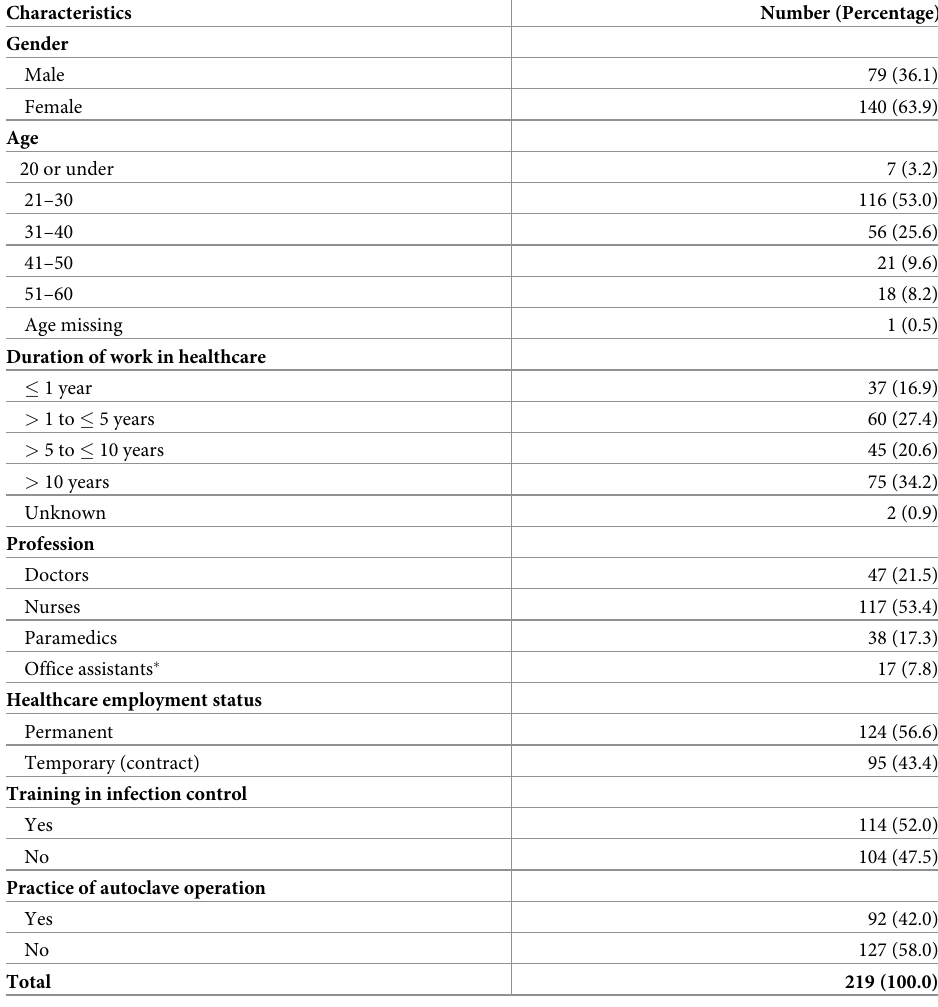
Table 1. Characteristics of healthcare workers participating in the survey.